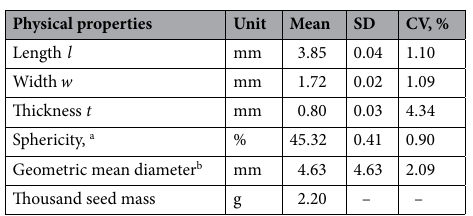
Table 1. The physical properties of carrot seeds (uncoated) used in the laboratory of the carrot seeder. 1 / 3 × 100% 14,21 . b Calculated as ( lwt ) 1 / 3 19,25 a Calculated as ( lwt ) l